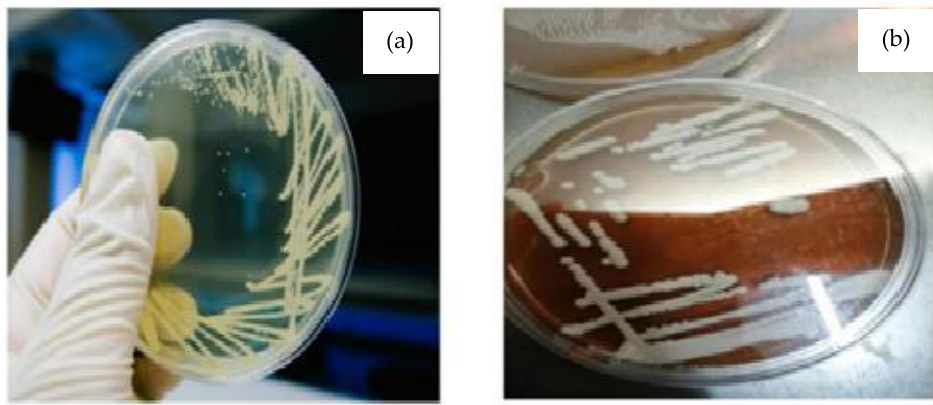
Figure 2. Cultivated strains of ( a ). S. cerevisiae ( b ). P. pastoris .